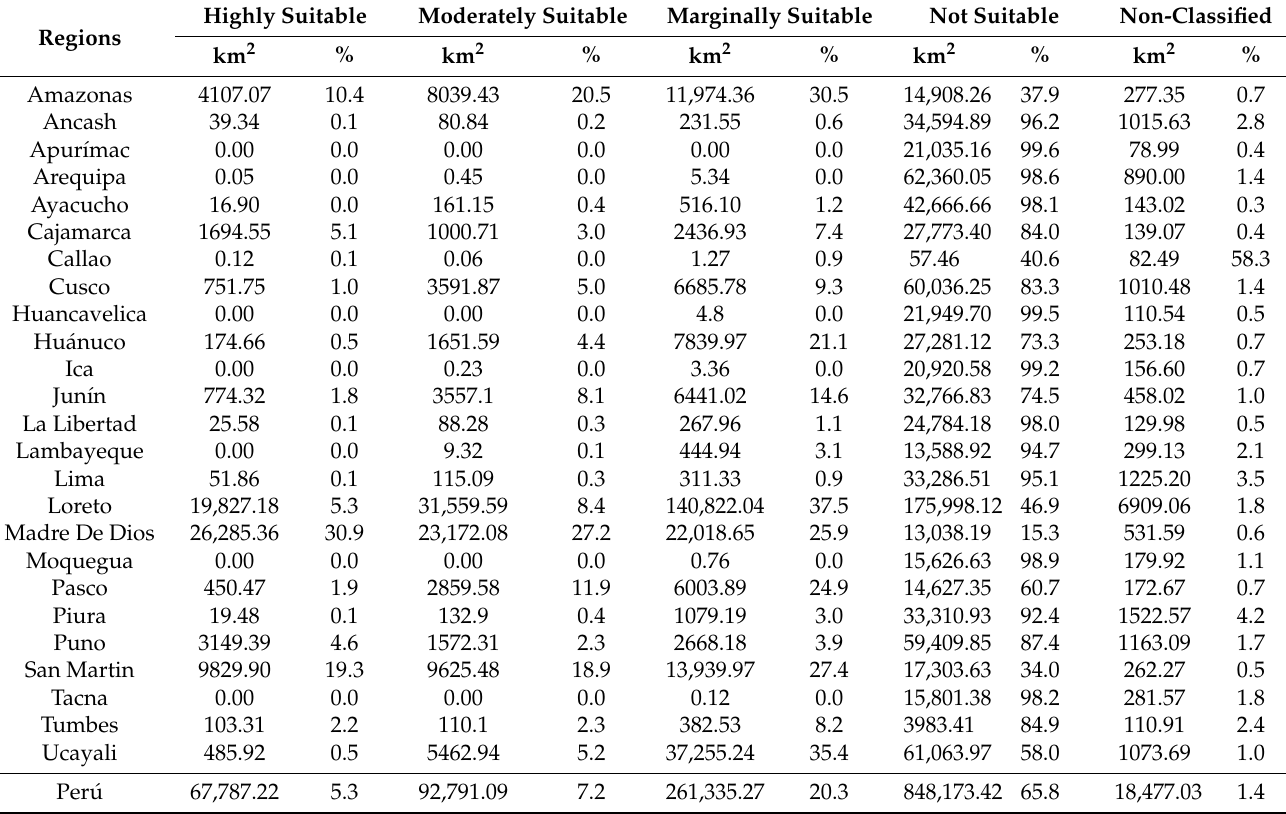
Table A3. Potential distribution of cocoa in Peruvian regions, MaxEnt